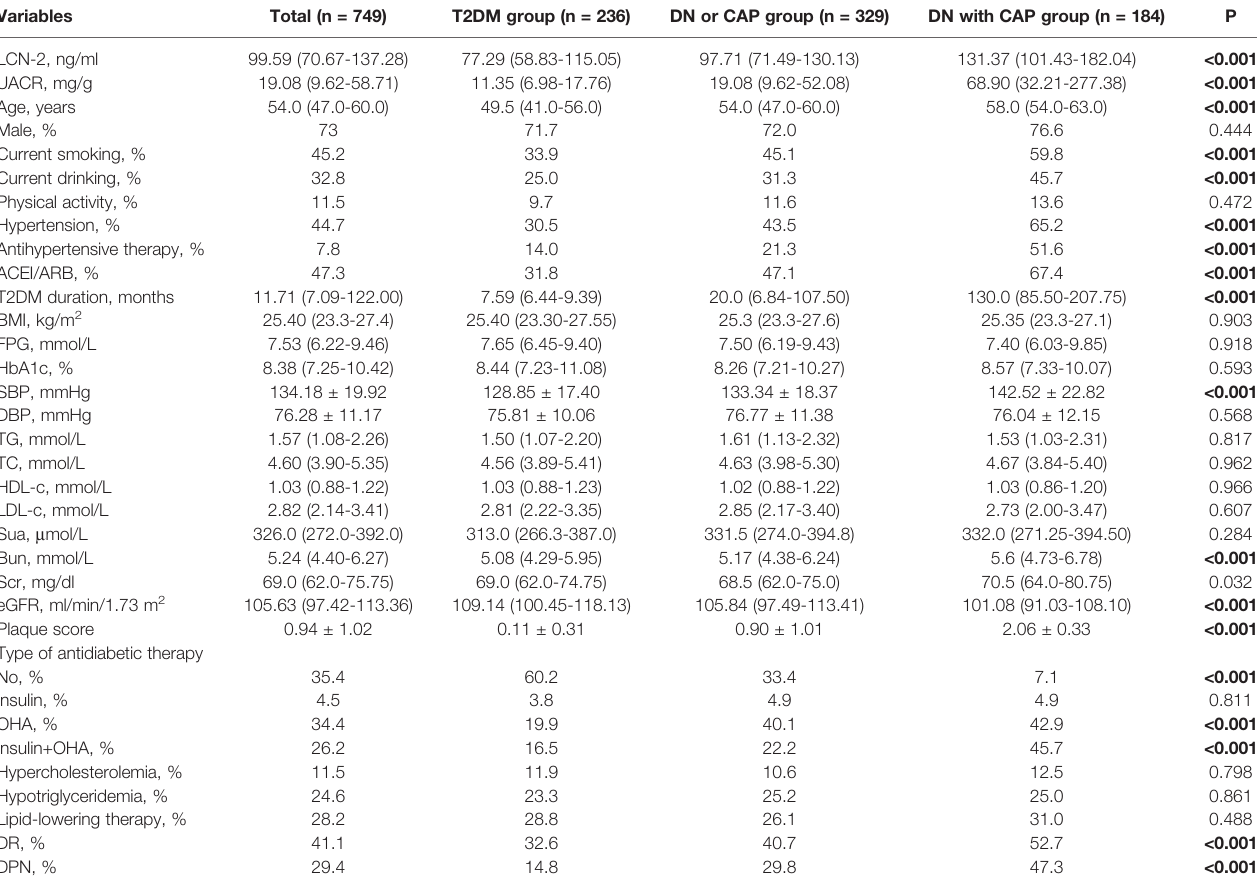
TABLE 2 | Comparison of clinical characteristic in T2DM patients with or without relevant compliations including DN and CAP. Variables Total (n = 749) T2DM group (n = 236) DN or CAP group (n =